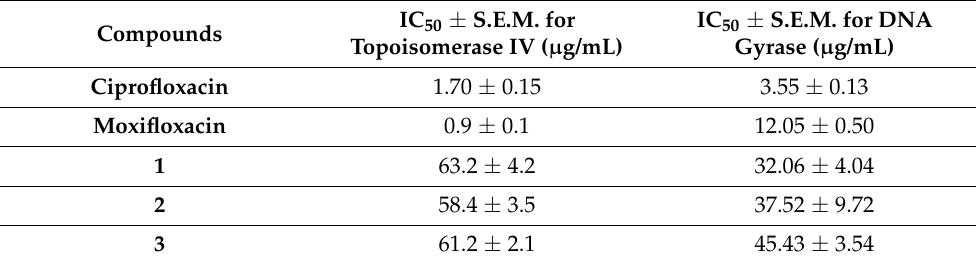
Table 5. The affinity of selected compounds towards bacterial type II topoisomerases, expressed as IC 50 ± SEM ( μ g/mL).